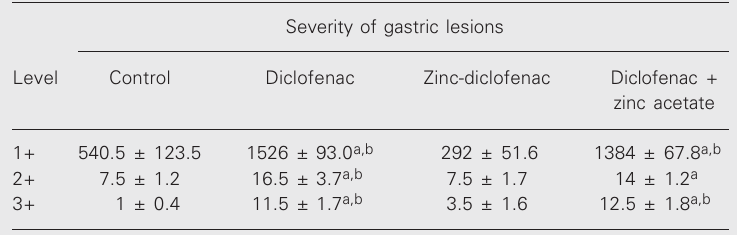
Table 2. Effect of diclofenac, zinc-diclofenac, and diclofenac plus zinc acetate on gastric lesions after per os administration.